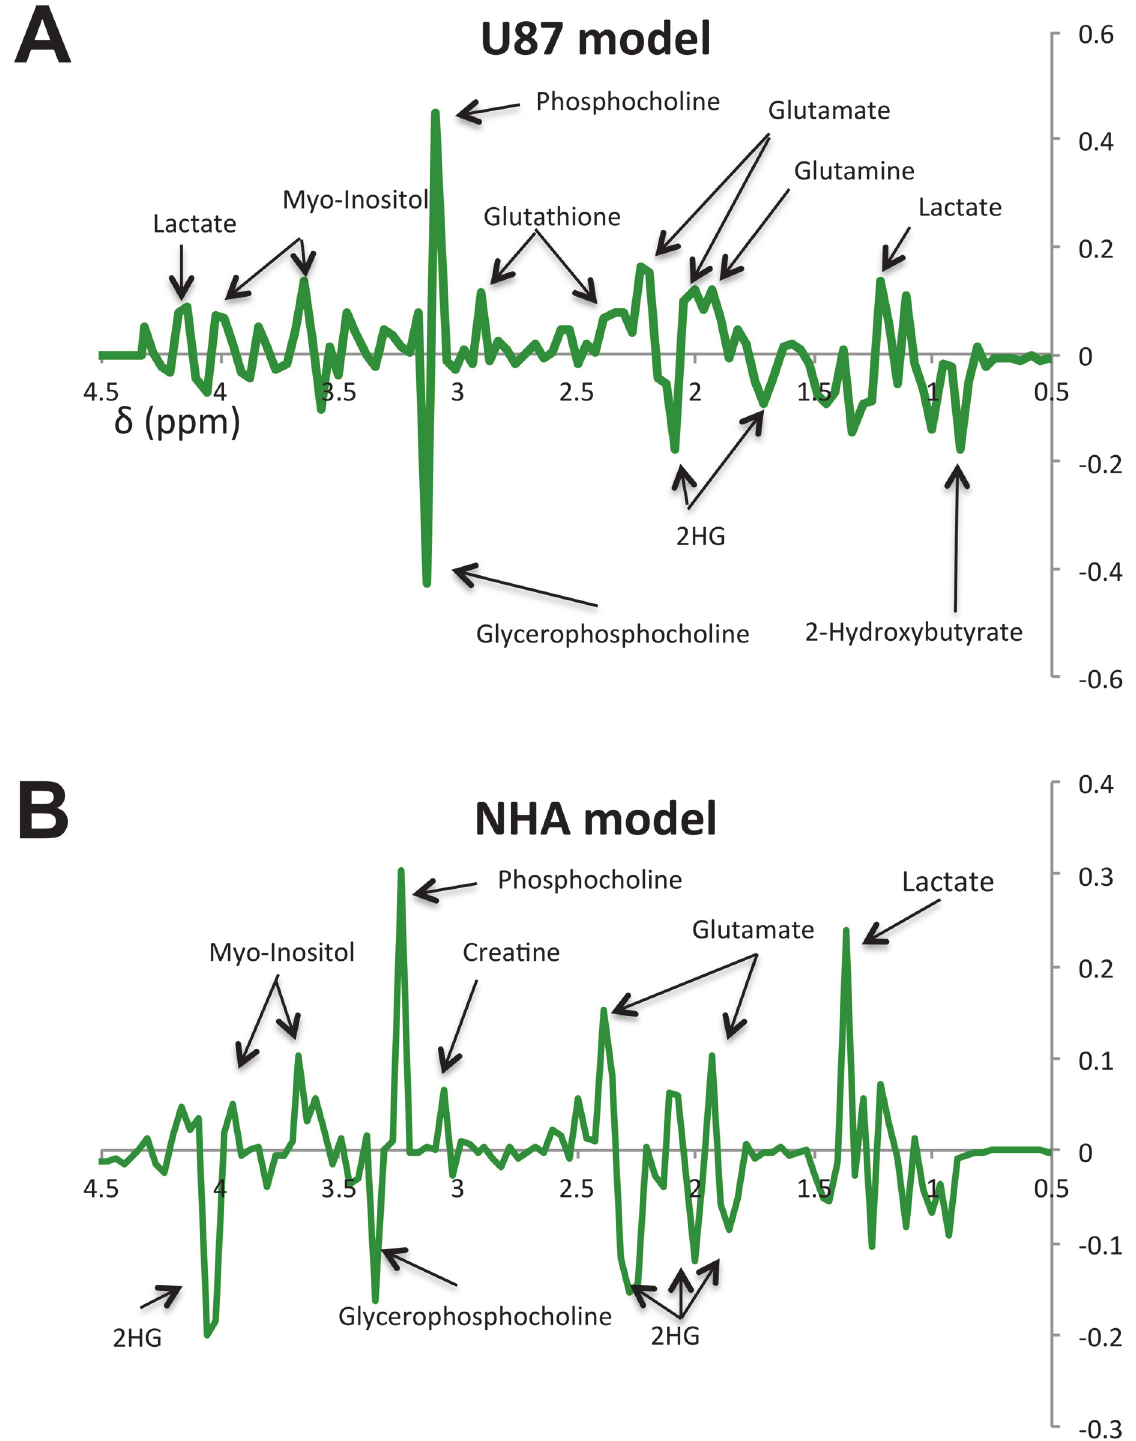
Fig 3. PCA loading plots identify metabolites that discriminate between IDHwt and IDHmut cells. Loading plots of PCA performed on the 1 H-MRS spectra are displayed for U87 (A) and NHA (B) cell extracts. The most significant resonance for separation between IDHwt and IDHmut cells are selected based on a significance level lower than 5.00e-02 by Hotteling ’ s T2 test.